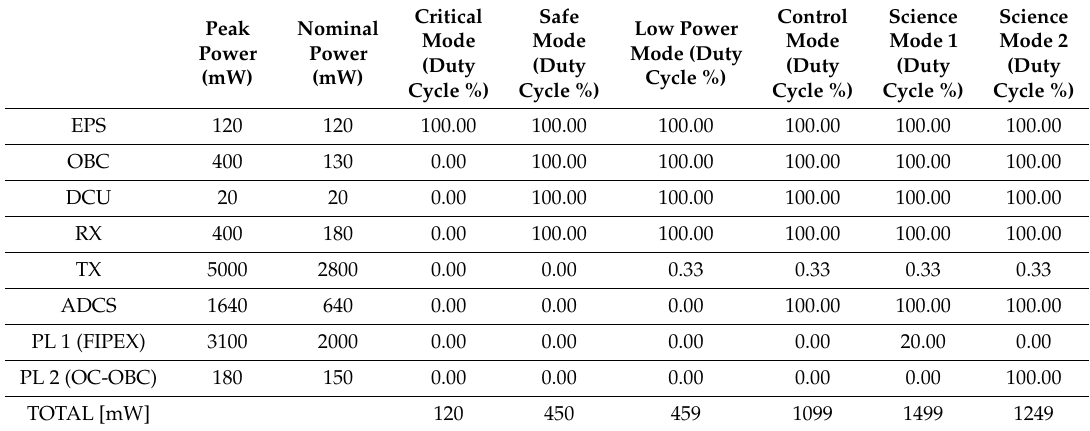
Table 2. SE01’s power